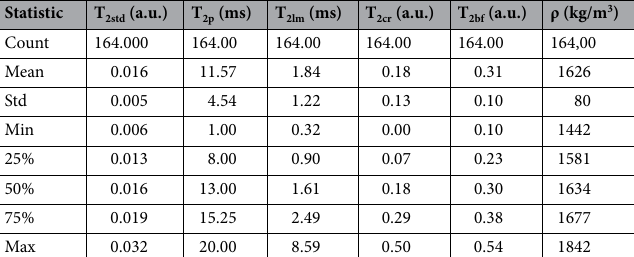
Table 2. Descriptive statistics of six input features used for XGB-FE model development.